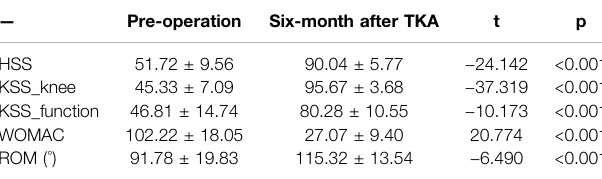
TABLE 1 | Clinical evaluation results before and 6-month after